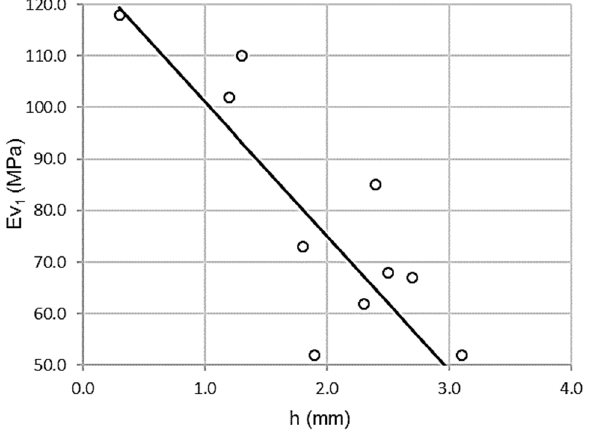
Figure 4. Scatterplot for wheel-tracking test and first modulus of the plate bearing test ( Φ 762 mm).